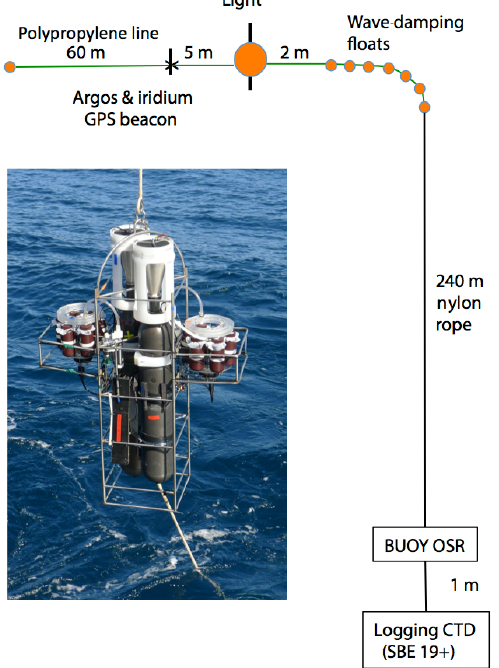
Figure A4. Photograph of the surface-tethered BUOY-OSR as de- ployed in January 2013. Also shown is the mooring configuration used in this study. The seven small floats spaced 1m apart are in- tended to minimize the effects of surface wave action on the up and down motion of the subsurface sediment trap. During the January 2013 deployment, depth was 237m ( ± 0.25m SD); maximum peak to trough vertical motion was